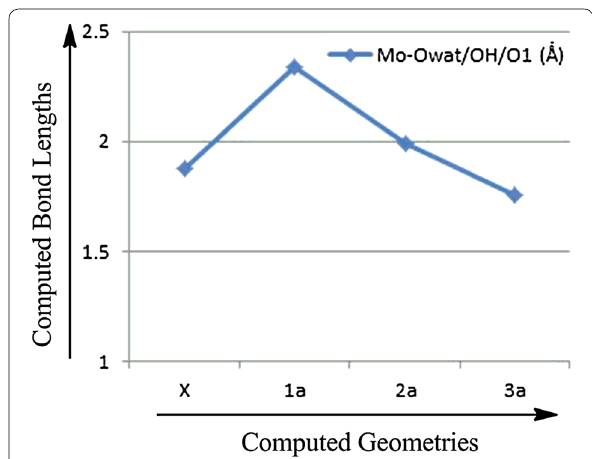
Fig. 6 Plot of crystallographic and computed metal–oxo species bond distances, where X represents the experimental data and 1a , 2a , 3a represents the calculated